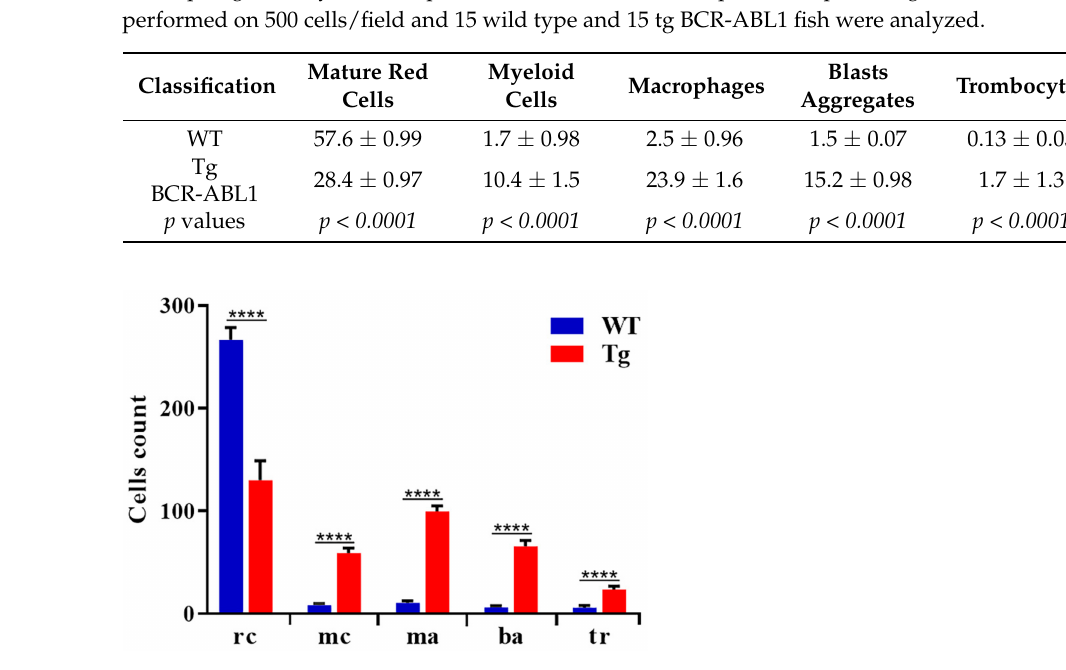
Figure 7. Quantification of different cell types in peripheral blood. Blood cells were counted manually based on their morphology and classified in different groups. We counted 500 cells per field for wild type ( n = 15) and Tg BCR-ABL1 ( n = 15). Statistical analysis was performed by unpaired, two-tailed T Test **** p < 0.0001. rc = red cells; mc = myeloid cells; ma = macrophages; ba = blast aggregates; tr =